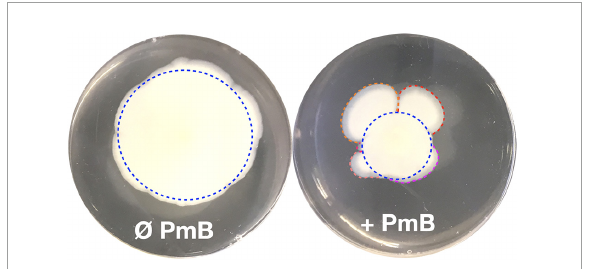
would expect (blue dotted circles) but shows protrusions (red, orange, violet, salmon, and pink curved lines). In absence of PmB, the motility pattern is much less heterogenous than in the presence of